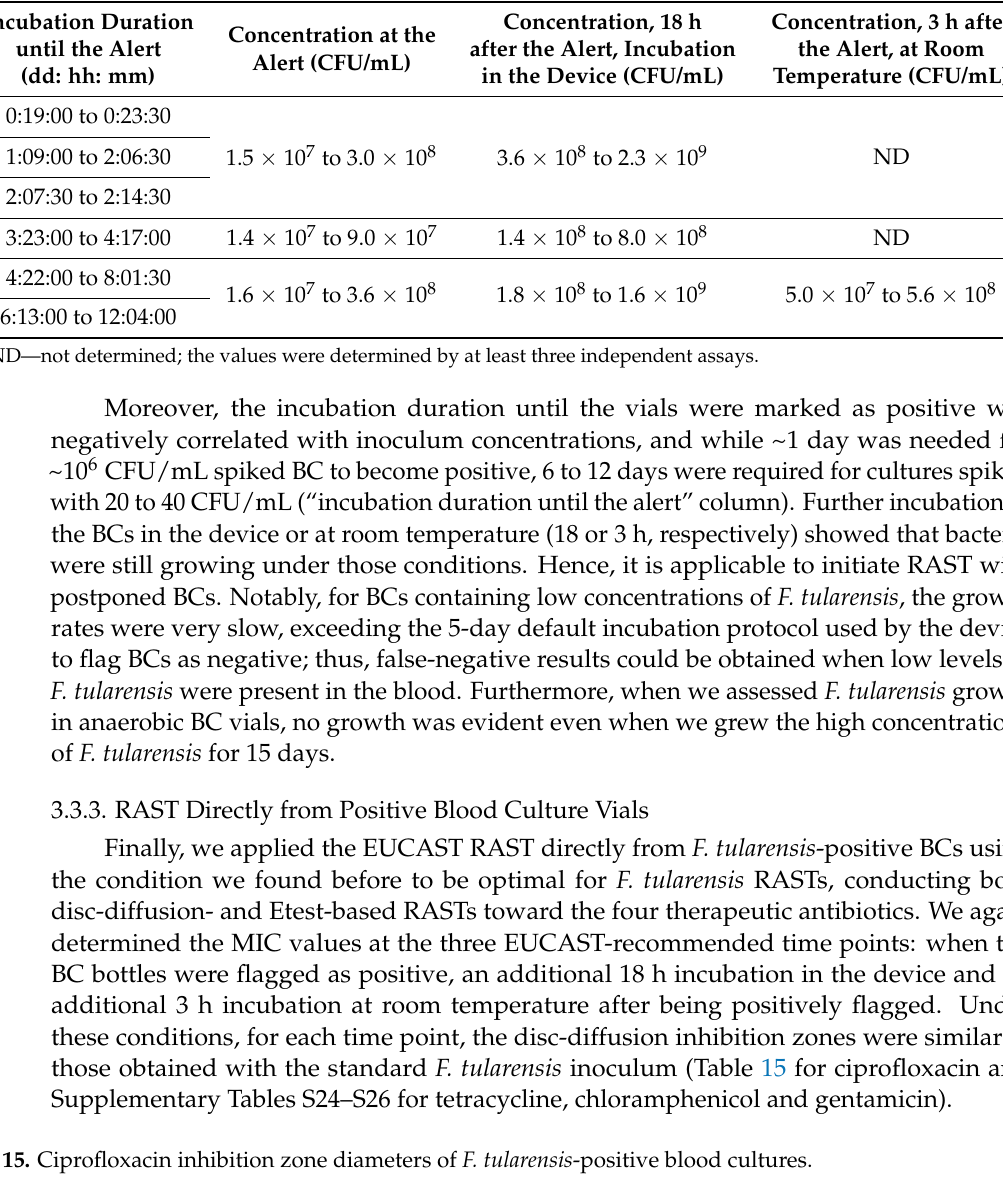
Table 14. Characterization of F. tularensis growth in blood cultures.